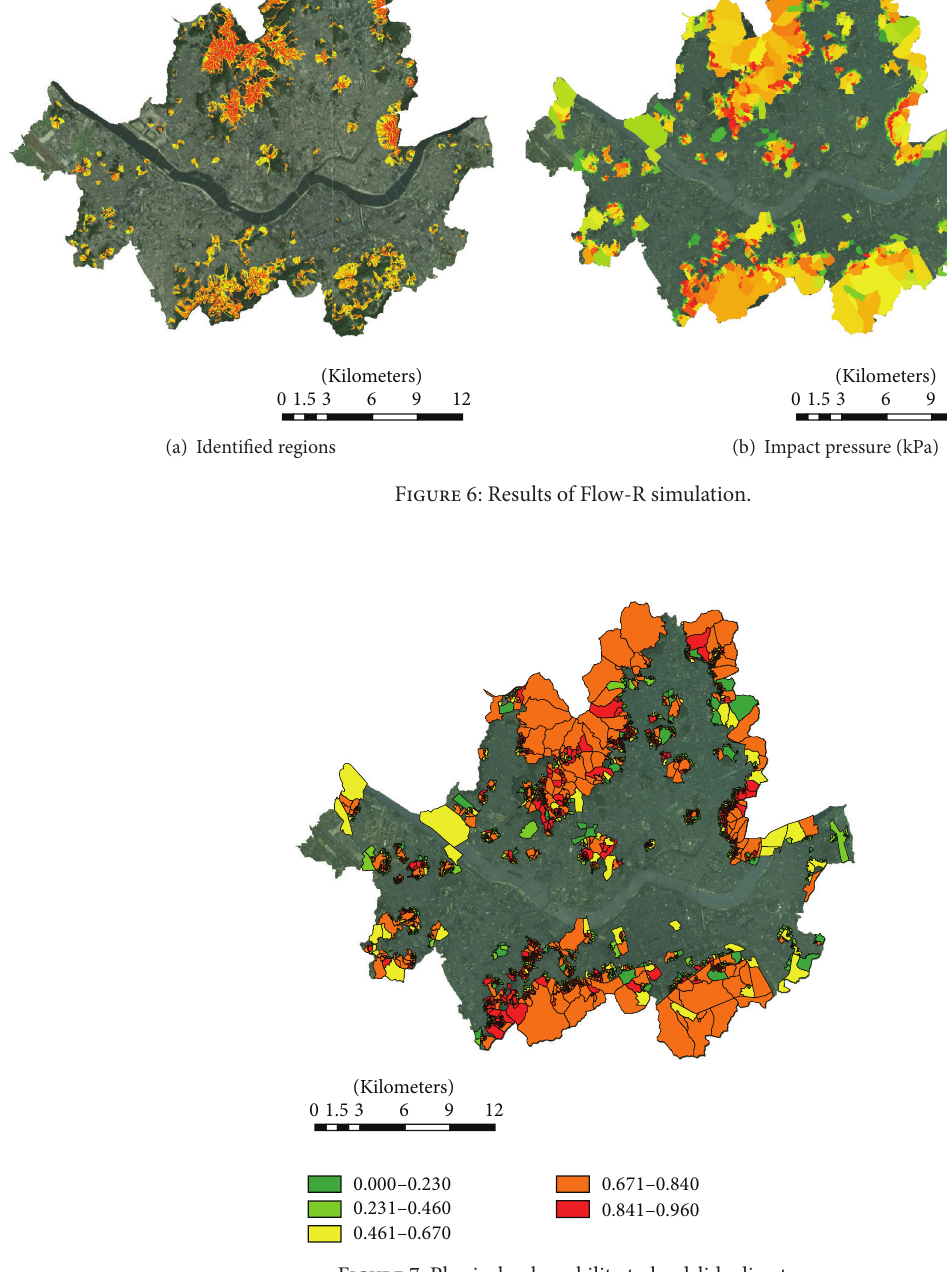
Figure 7: Physical vulnerability to landslide